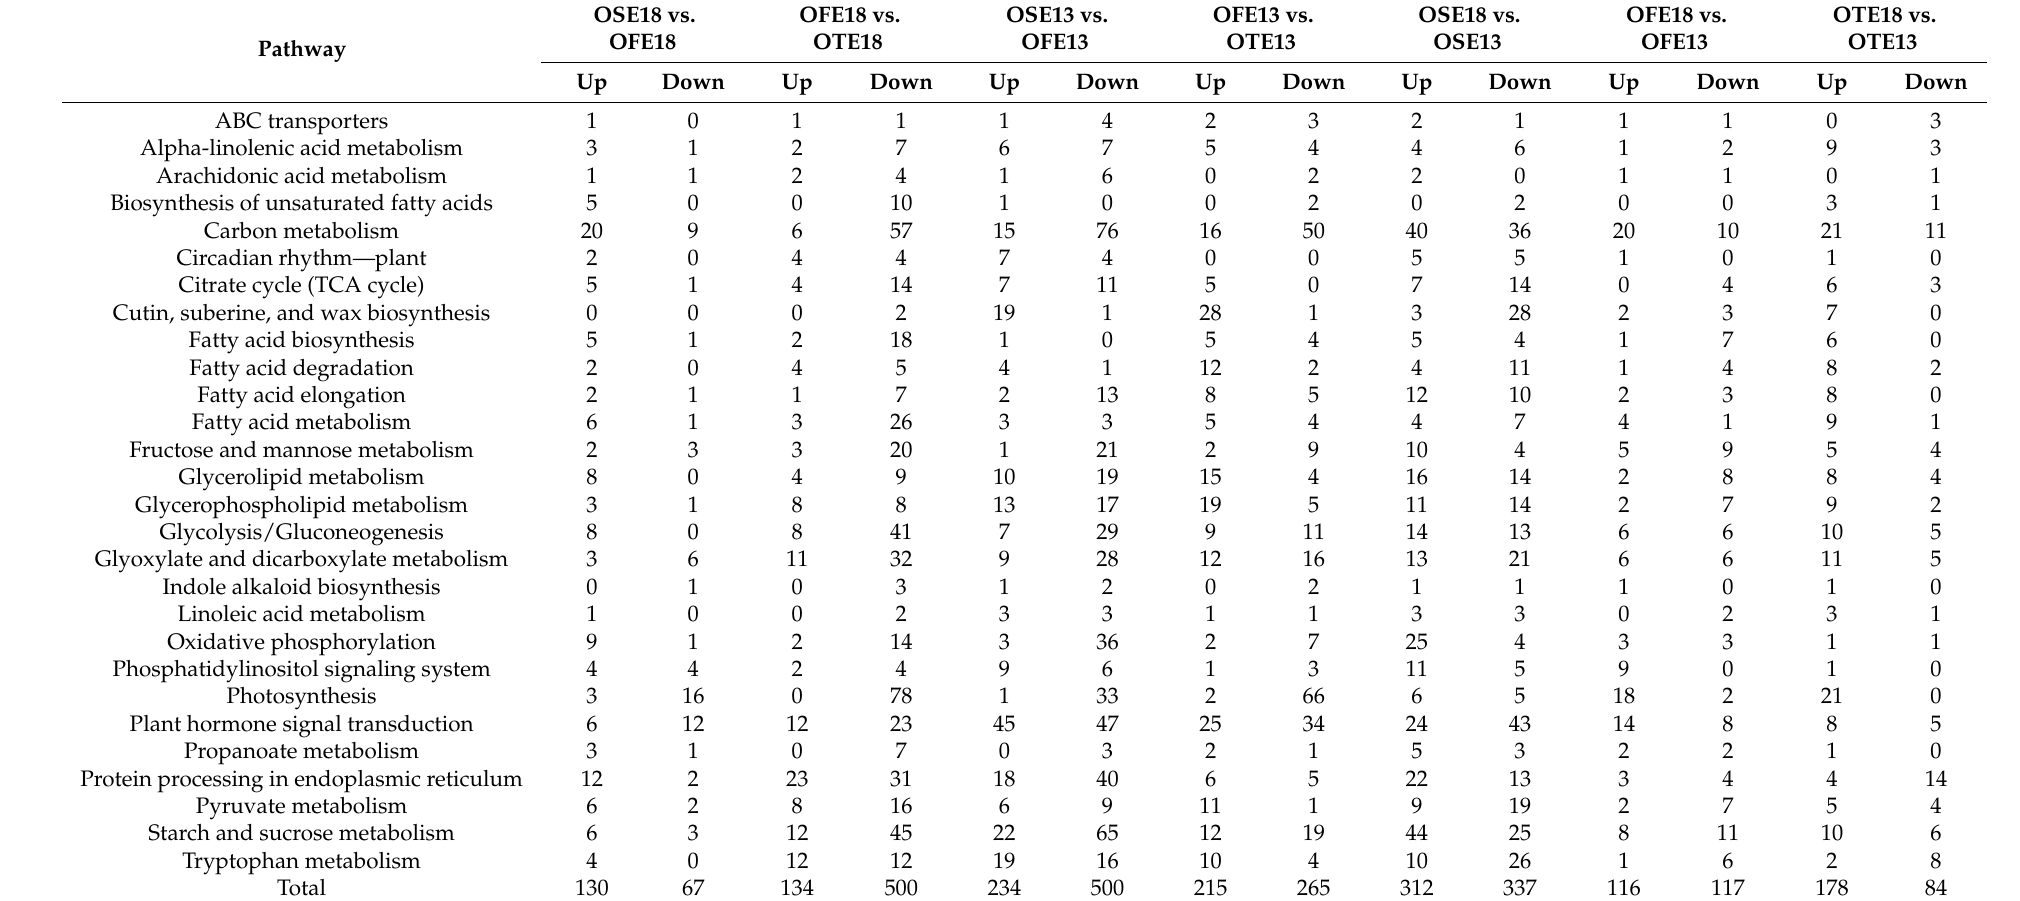
Table 4. Differentially expressed genes in pathways involved in and/or related to fatty acid metabolism from the STSL at the LNT and HNT. OSE18 Pathway